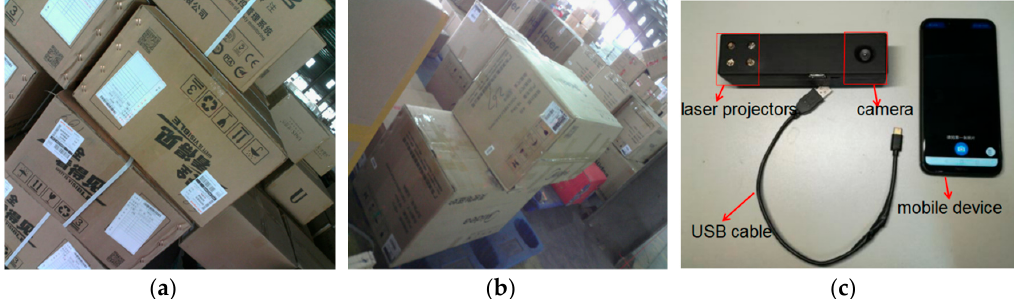
Figure 1. Box in the distribution center and design prototype; ( a ) and ( b ) show the box in the distribution, and ( c ) shows the proposed system prototype.